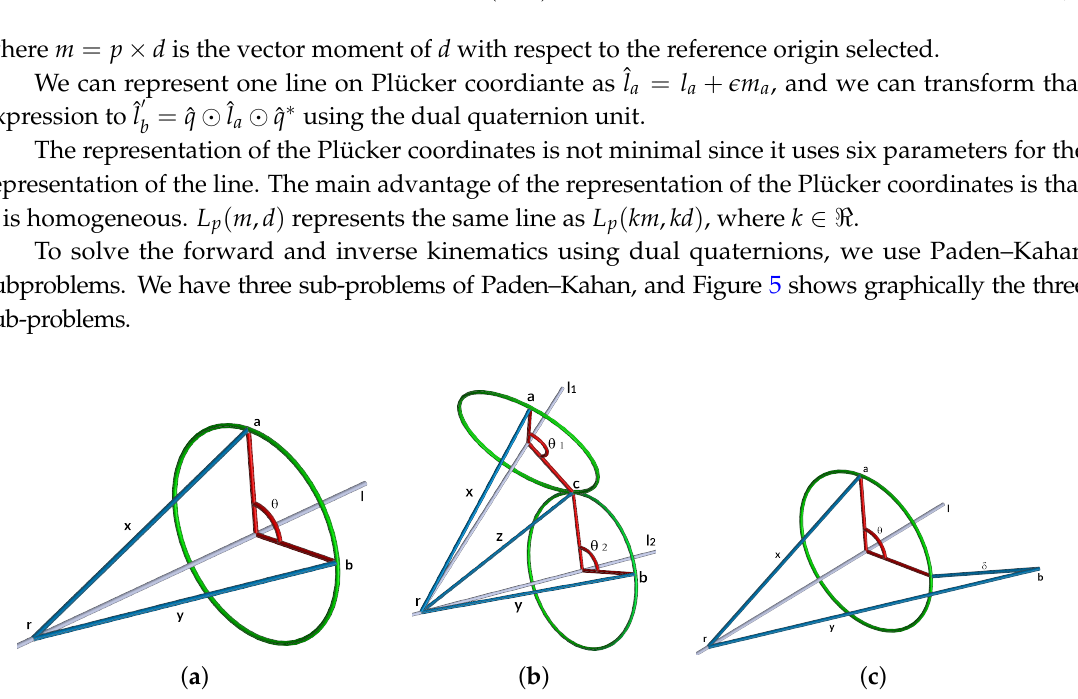
Figure 5. Paden–Kahan sub-problems: ( a ) sub-problem 1; ( b ) sub-problem 2.; ( c ) sub-problem